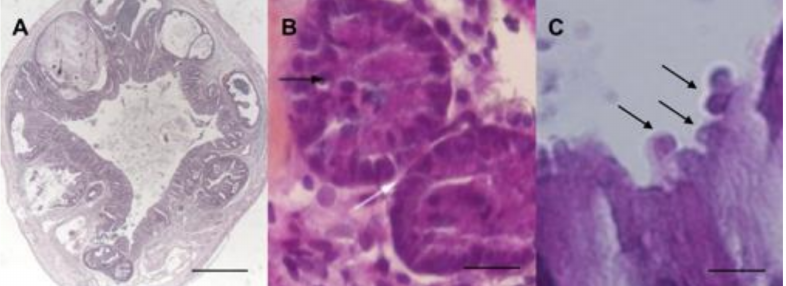
( A ) Adenocarcinoma of the ileo-caecal region in a Dex-treated Severe Combined Immunodeficiency (SCID) mouse after 62 days of C. parvum infection. Scale bar, 1000 µ m. ( B ) Low-grade intraepithelial neoplasia in a murine colonic explant after 27 days of C. parvum infection characterized by reduction of the interglandular space (white arrow), and loss of nuclear polarity with slight pseudostratification (black arrow). Scale bar, 25 µ m. ( C ) Cryptosporidium developmental stages were observed in apical position (arrows) within the epithelial cells in a human colon adenocarcinoma of a Lebanese patient. Scale bar, 5 µ m. (Hematoxyline and Eosine). Photomicrographs ( B , C ) were slightly modified from [41] and [40],